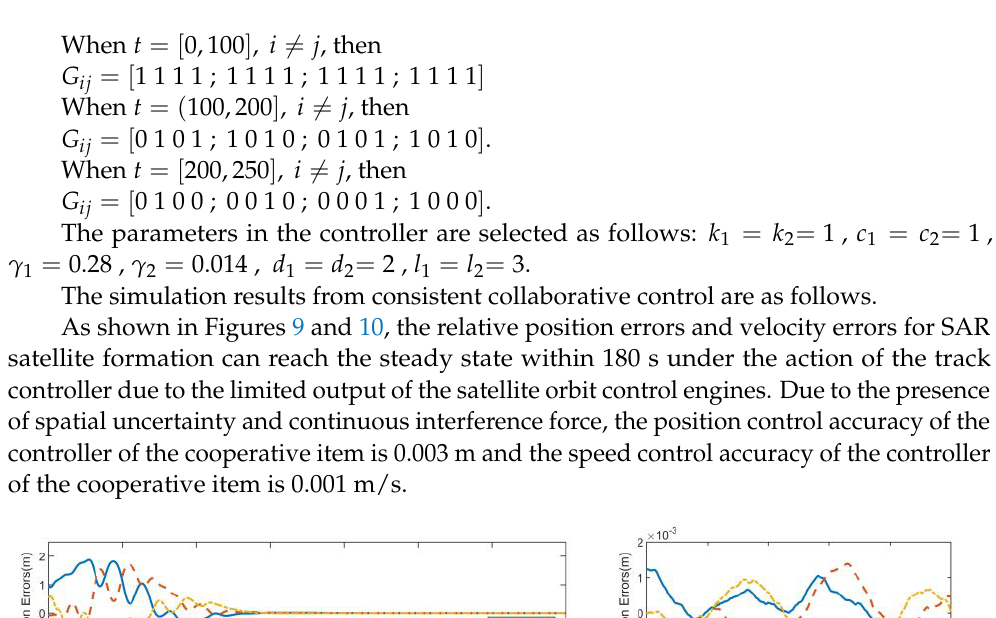
errors; ( b ) S3 position errors and S4 position errors.